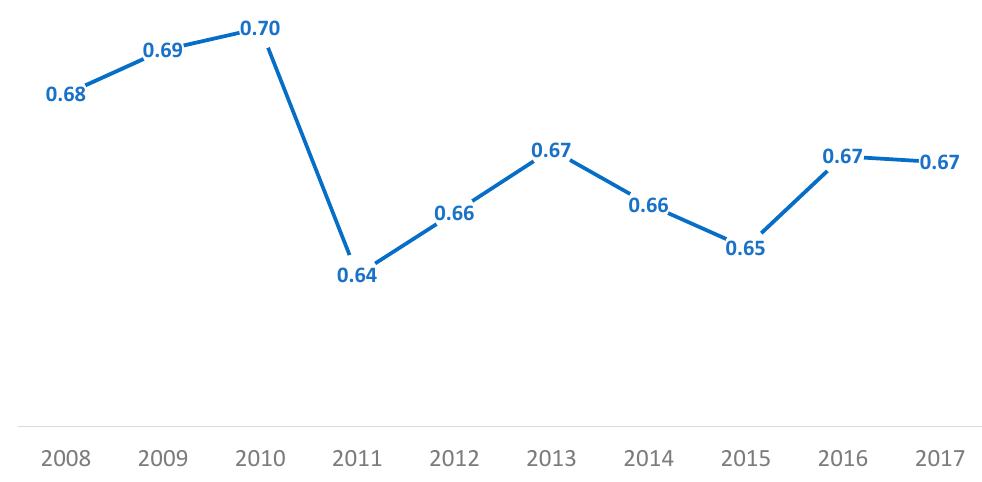
Figure 4. Average energy-efficiency score of the 25 countries from 2008 to 2017.